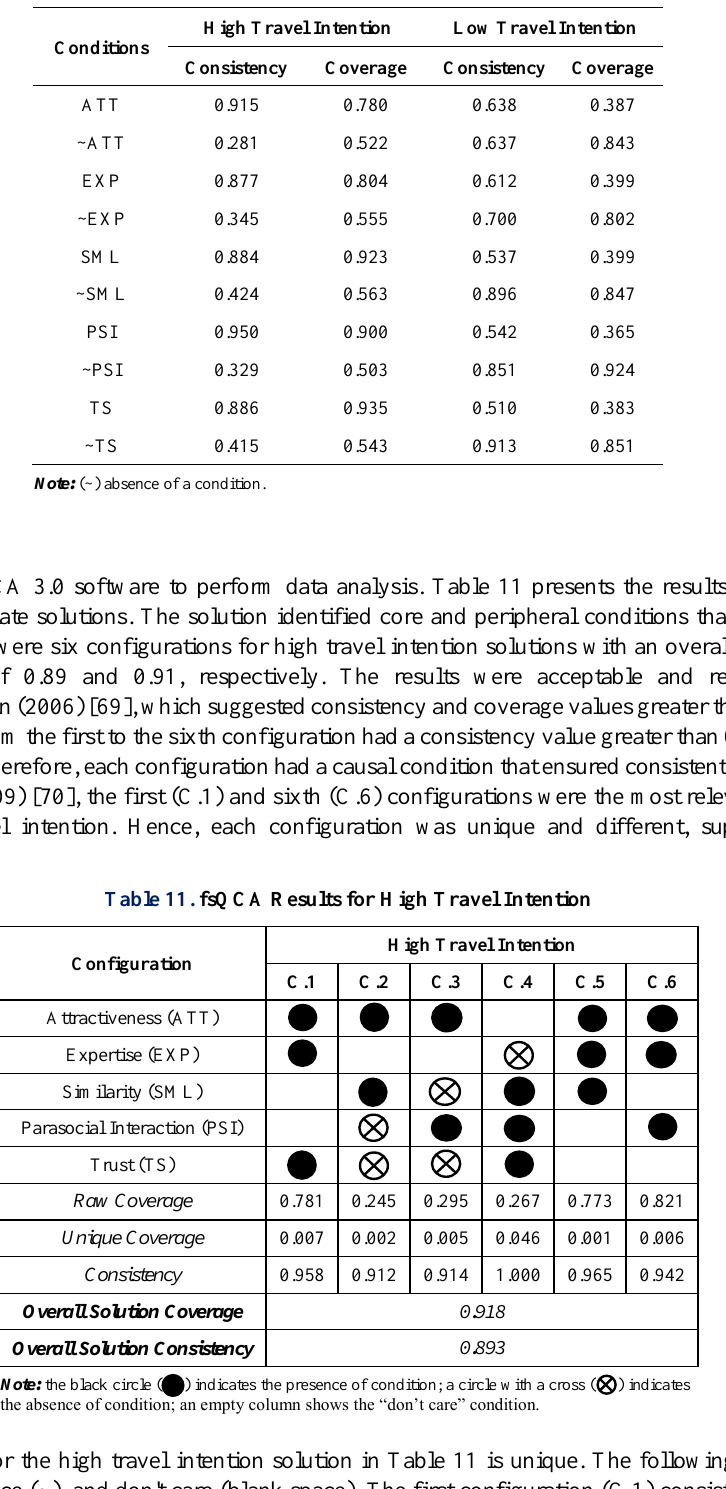
Table 10. fsQCA Analysis of Necessary Conditions